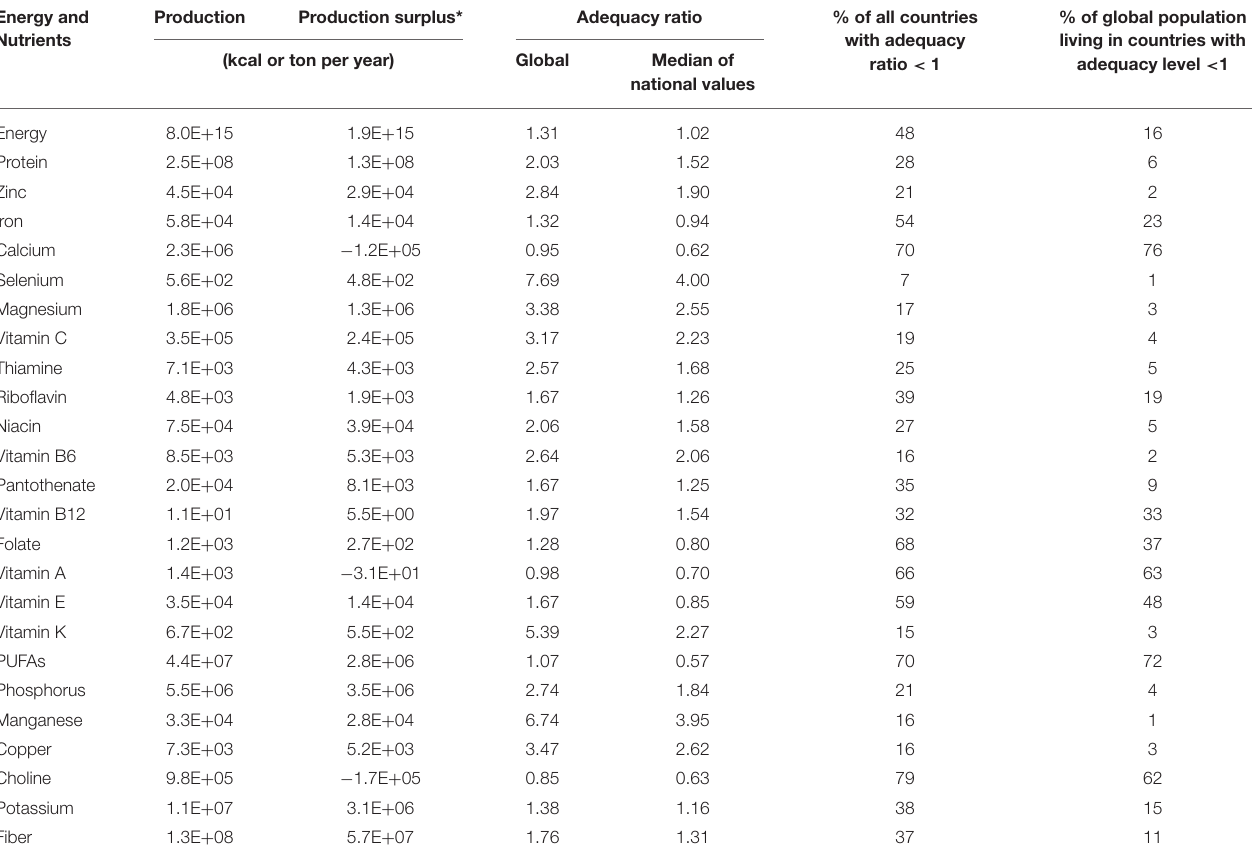
TABLE 1 | Global dietary nutrient production and adequacy. Energy and Nutrients